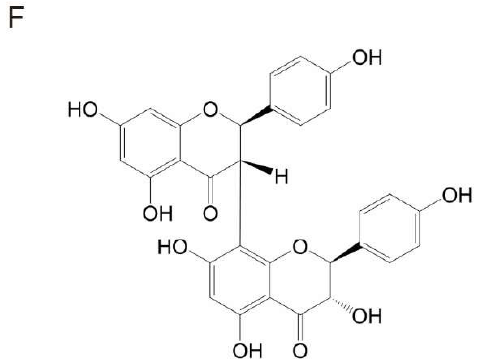
Figure 1. GB1 improves lipid deposition in liver cells. HepG2 cells were exposed to OA (500 µ M) and PA (250 µ M) for 24 h, and were then subjected to Wy14643 (PPAR α agonist) and GB1 (25 µ M, 50 µ M) for 24 h. ( A ) HepG2 cell activity under different concentrations of GB1. ( B ) HepG2 cell activity under different concentrations of OA&PA. ( C ) HepG2 cell activity under 50 µ M GB1 and different concentrations of OA&PA. ( D ) Triglycerides level in HepG2 cells under different conditions. ( E ) Representative Oil-Red-O stained images (400 × ). ( F ) Chemical structure of GB1. All data were presented as mean ± SEM of three independent experiments. **, p < 0.01, ***, p < 0.001; ns, not